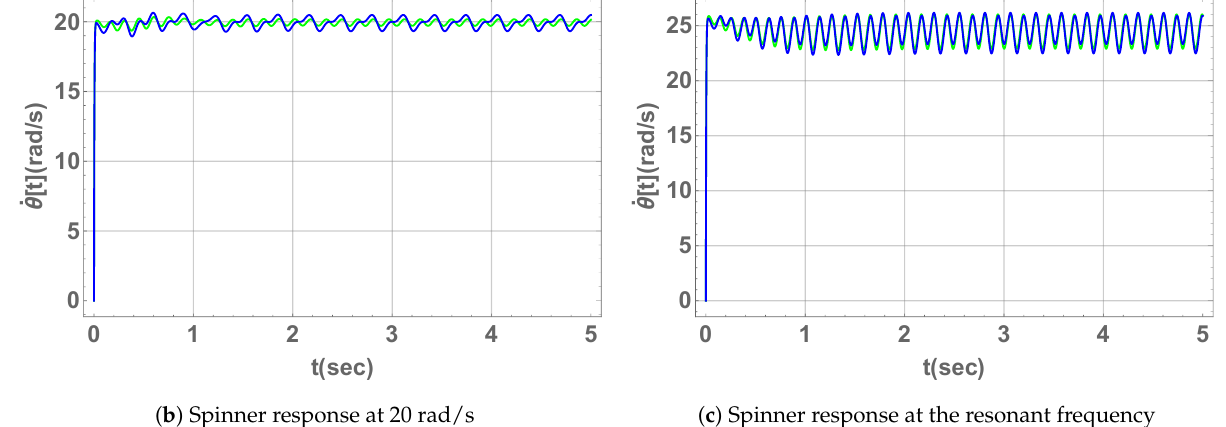
( c ) Spinner response at the resonant frequency Figure 7. Attached to ground, Spinner